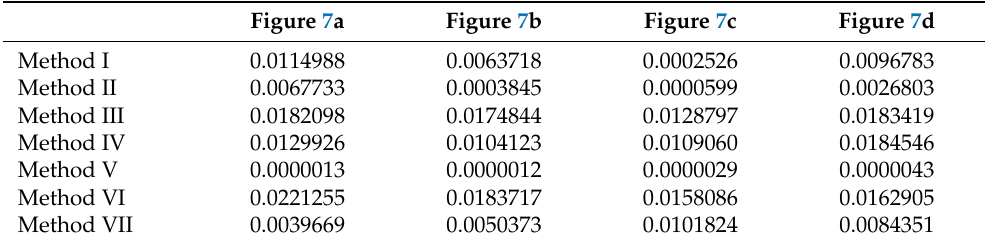
Table 8. Values of the variance of the differences between the maximum and minimum values calculated according to (2), (8), (11), (14), (22), (26), and